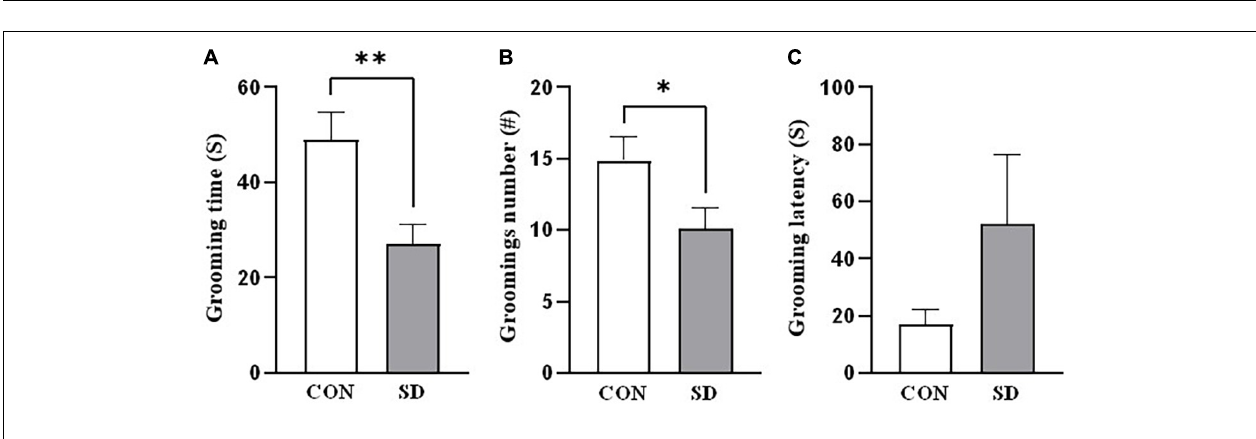
FIGURE 2 | Depression-like behavior. Depression-like behavior was assessed in rats using the sucrose splash test. The time the rats spent grooming (A) , the number of grooming sessions (B) , and the latency to start the first grooming session (C) , following splashing of the dorsal coat with 10% sucrose. Bars represent means ± SD. Data were analyzed using t -test. ( ∗ ) Significantly different from control at p < 0.05. n = 6–8 rats per group. ( ∗∗ ) Significantly different from control at p < 0.001. Group designations: control (CON), sleep deprivation